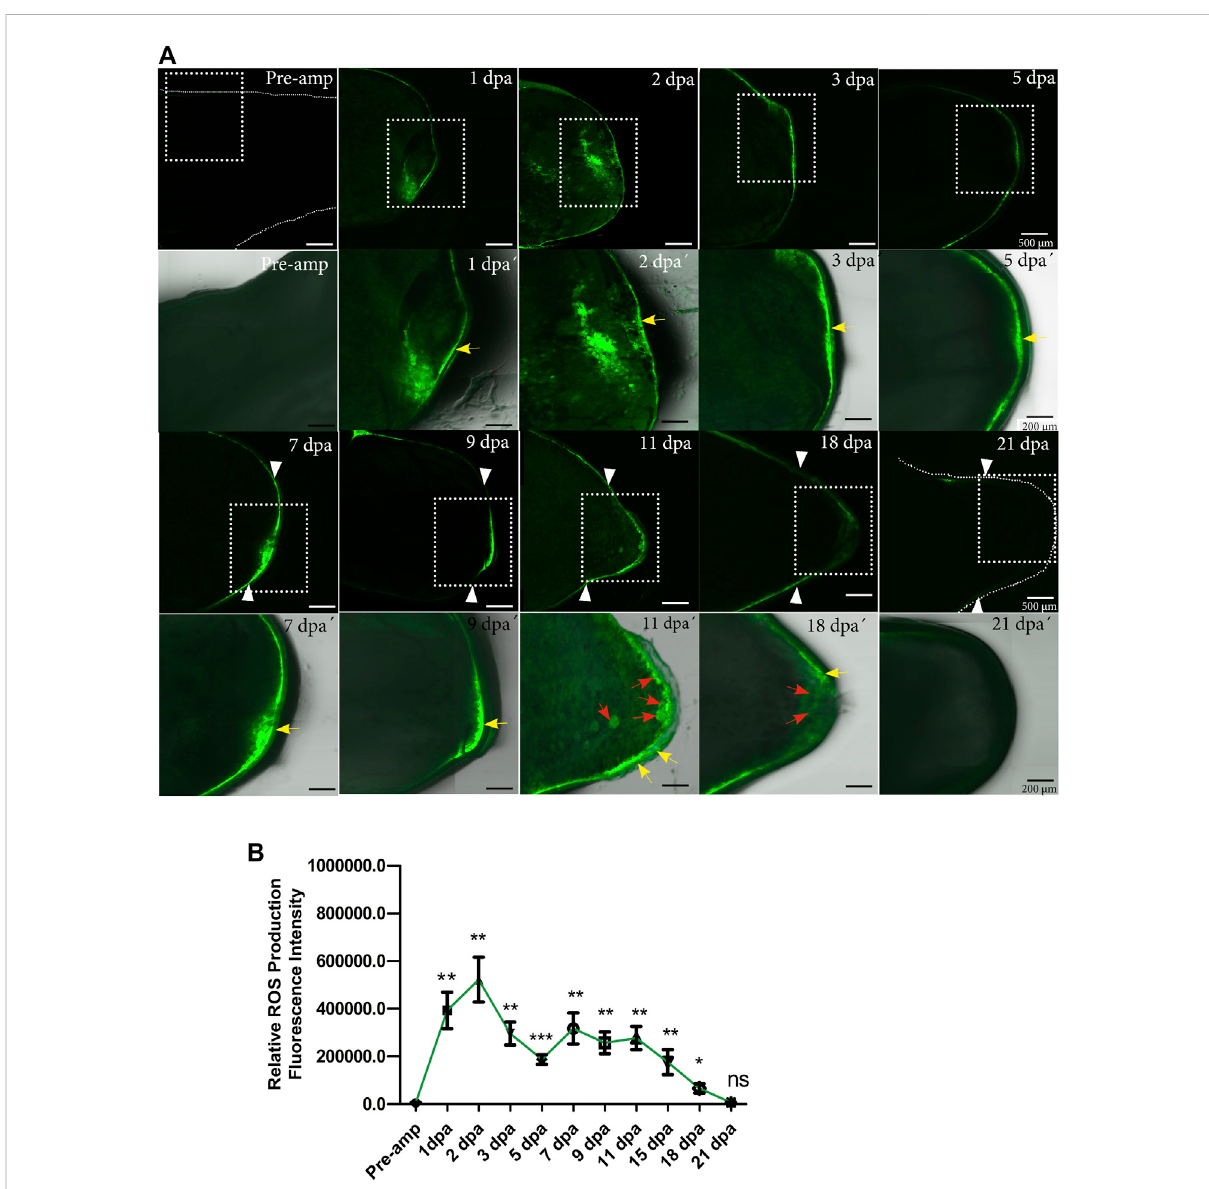
FIGURE 1 ROSproductionduringlimbregenerationin A.mexicanum . (A) representativeimagesofROSproductionacquiredbyconfocalmicroscopy.The pre-amputation image represents the medial area of the non-amputated humerus (basal level of ROS production). ROS production was detected at the amputation plane at 1, 2, 3, and 5 dpa. At 7 dpa and 9 dpa ROS was detected in the apical epithelial cap (AEC) and at 11 dpa in the AEC and developingblastemaregion.Whitearrowheadsrepresenttheamputationplane.Awhiteboxwithadashedlineisshownathighermagni fi cation in lower panel images acquired with differential interference contrast (DIC) in conjunction with fl uorescence images for anatomical details. Yellow arrows indicate epithelial localization of ROS and red arrowslocalization in blastema cells. (B) , Semi-quanti fi cation of relative fl uorescence intensity. Fluorescence levels show two apparent waves of ROS production between 1dpa and 3 dpa for the fi rst wave, and between 7 and 15 dpa, for the second wave of ROS production. One-way ANOVA with a Tukey post-hoc was performed to compare each point with basal levels of pre- amputationROSproduction(n=10foreachpoint,5animalsperpoint).Dataareexpressedasmean±SEM(meanstandarderror).*** p < 0.001,** p < 0.01, * p <